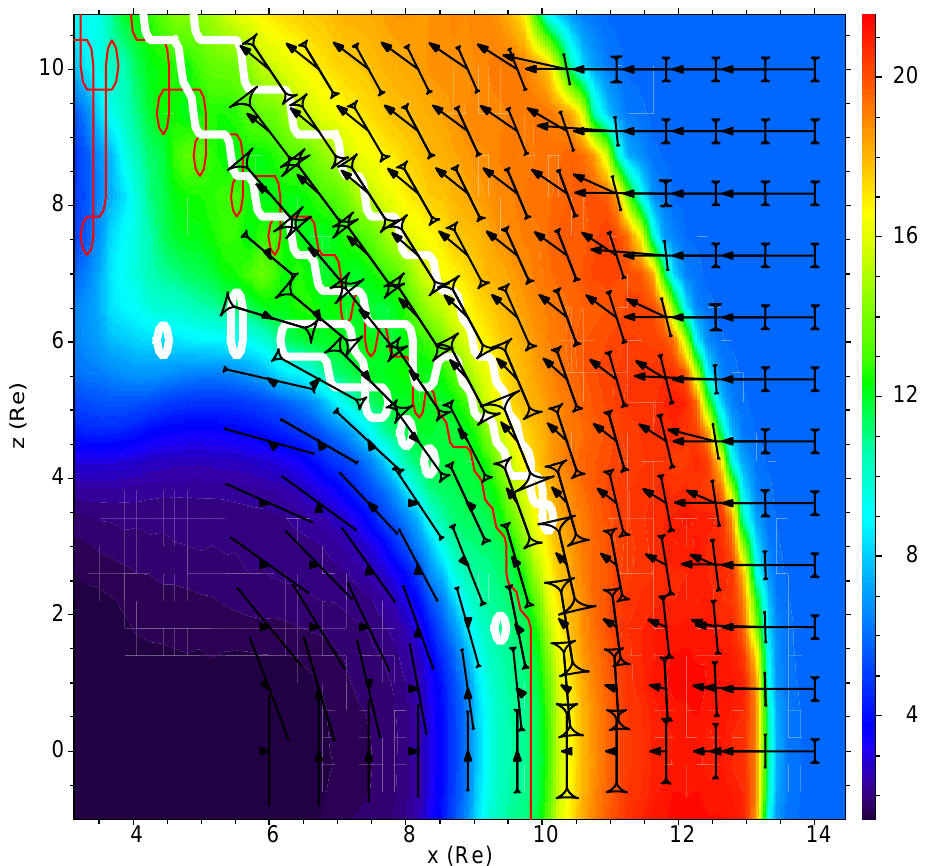
Fig. 8. The slow mode front in the GSE y=0 plane with the plasma density as the background for Run 1. The open-closed magnetic field boundary is shown as a red zigzag curve, which is defined as the boundary between field lines, with both ends connecting to the Earth and field lines with only one end connecting to the Earth. The black arrows show the flow velocity and the black straight lines are along the local magnetic field with the slow mode wave group velocities on the ends of them. The closed white zigzag curves fit pattern 2 of Fig. 7 inside of which pattern 1 in Fig. 7 exists. The segment of a white curve where plasma flows into the region circled by the white curve is a slow mode